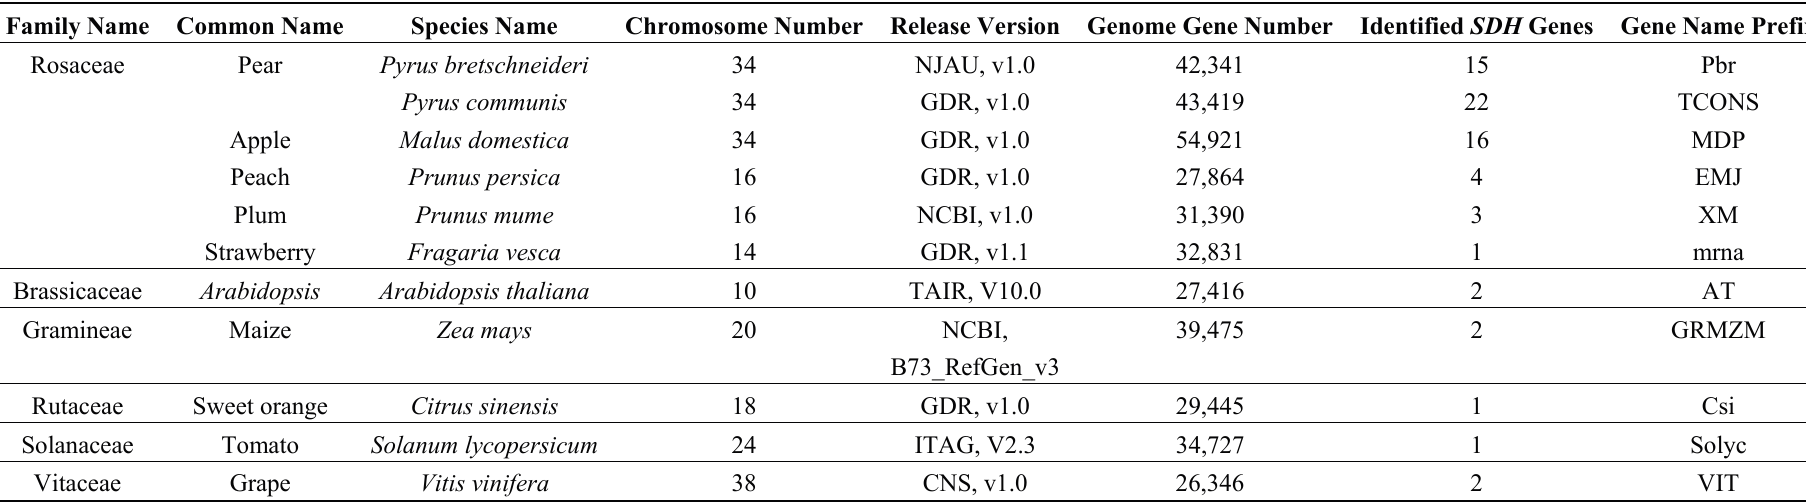
Table 2. Sorbitol dehydrogenase (SDH) homologous genes identified in six Rosaceae species and five non-Rosaceae plant